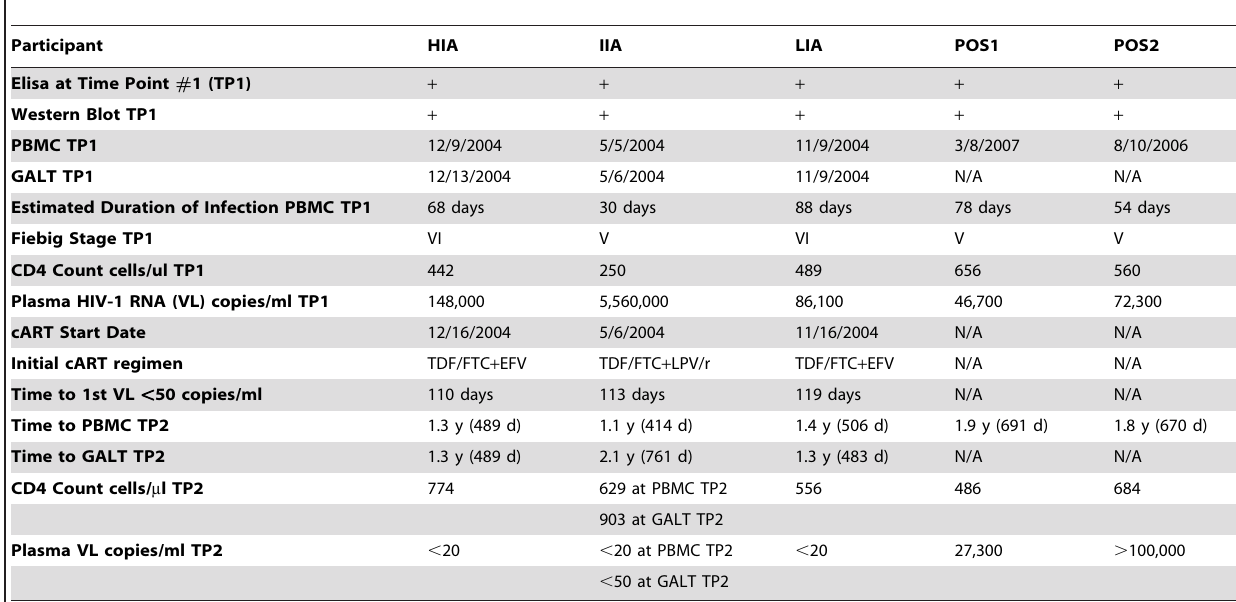
Table 1. Clinical profile and ARV treatment history for study participants and positive controls.